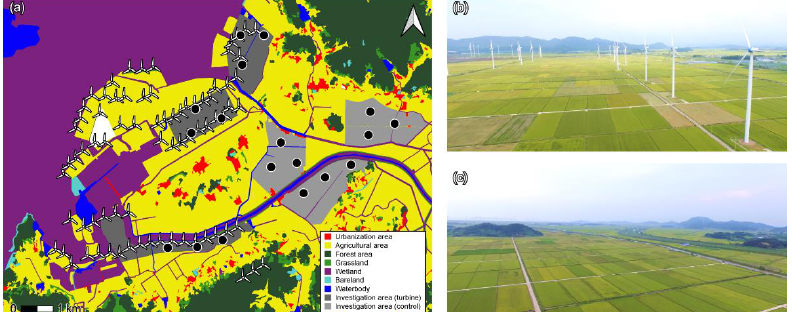
Figure 1. The land cover map with the location of the field investigation in this study and two photos of paddy fields with and without wind power generators, taken by drone. ( a ) Land cover map of field investigation areas. Three investigation sites were contained within each of the three areas with wind power generators (wind turbine group), and the other three investigation sites were contained within each of the three areas without wind power generators (control group). The land cover type of both investigation areas was paddy fields. ( b ) Photo of investigation area with wind turbines (wind turbine group). ( c ) Photo of investigation area without wind turbines (control